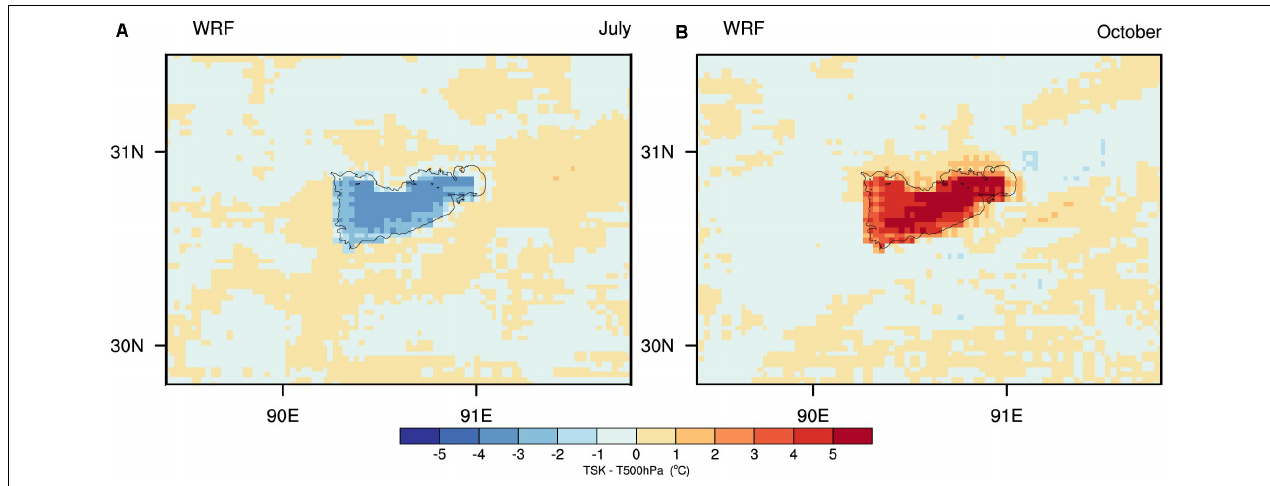
FIGURE 11 | Spatial pattern of the difference between the simulated results by the WRF_lake and the WRF_nolake, which is the gap between the lake surface and 500 hPa temperatures (units: ◦ C) in July (A) and October (B) of 2008.